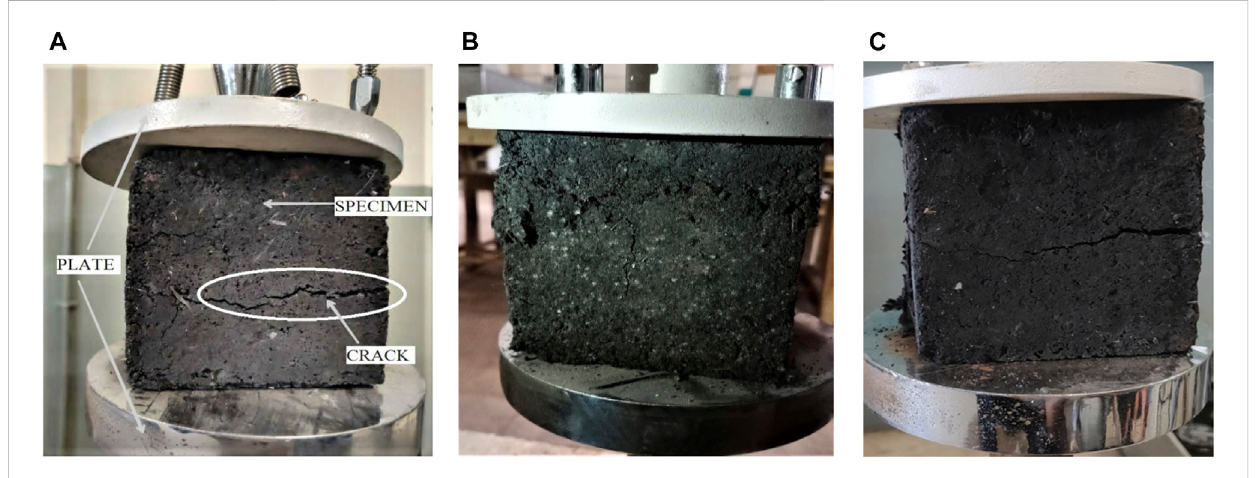
FIGURE 14 Development of cracks in cube specimens (A,B, and C)